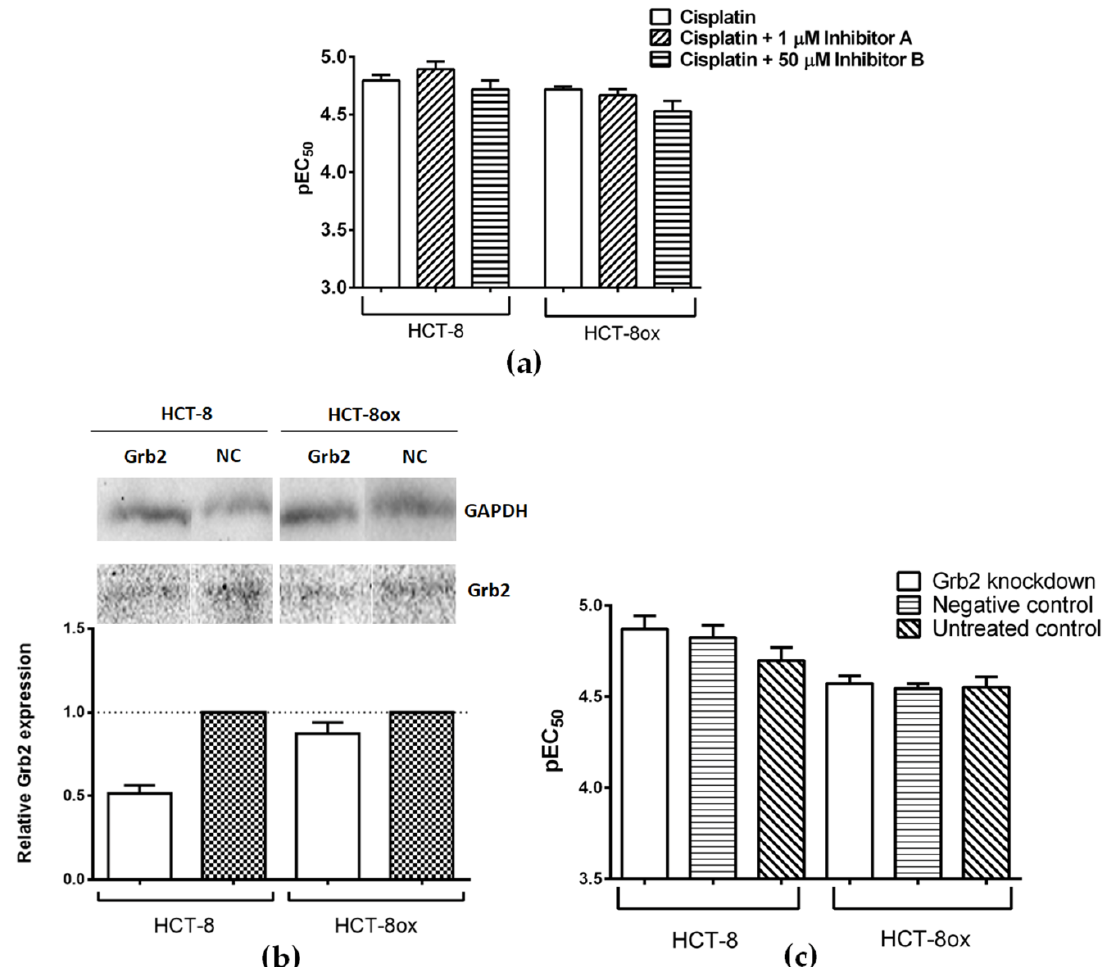
Figure 4. ( a ) Cisplatin cytotoxicity in HCT-8 and HCT-8ox cells alone or upon co-incubation with either 1 µ M inhibitor A or 50 µ M inhibitor B (mean ± SEM, n = 5–6); ( b ) representative Western Blots and densitometric quantification of protein expression after treatment with Grb2-specific and negative control (NC) siRNA in HCT-8 and HCT-8ox cells, where GAPDH served as a loading control (mean ± SEM, n = 3); ( c ) cisplatin cytotoxicity in HCT-8 and HCT-8ox cells after Grb2 knockdown, prior treatment with negative control siRNA, or no pre-treatment (mean ± SEM, n =